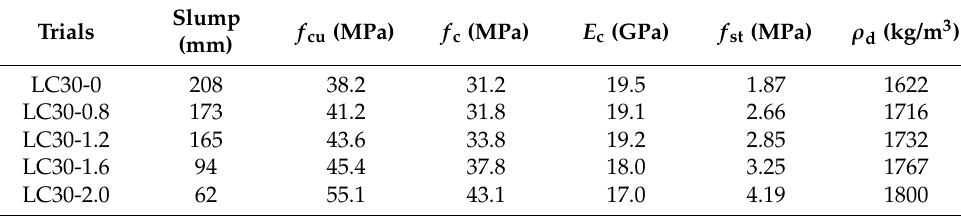
Table 6. Test results of slump, mechanical properties and apparent dry density of